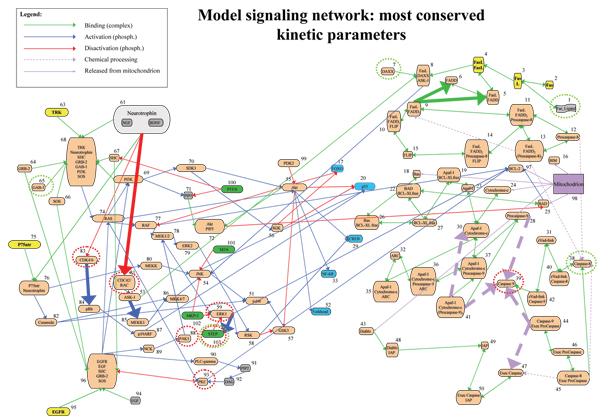
Variability of solutions. Most conserved kinetic parameters. The coefficient of variation StdDev(log10Ki)/Mean(log10Ki), where {Ki}i = 1...n is any kinetic parameter, was computed for every parameter across the entire ensemble of solution sets. The kinetic parameters with a ratio ≤ 0.33 are highlighted in the network graphical representation: thick arrows refer to kinetic rates of protein-protein interaction, the red circles refer to degradation rates and the green circles to synthesis rates.